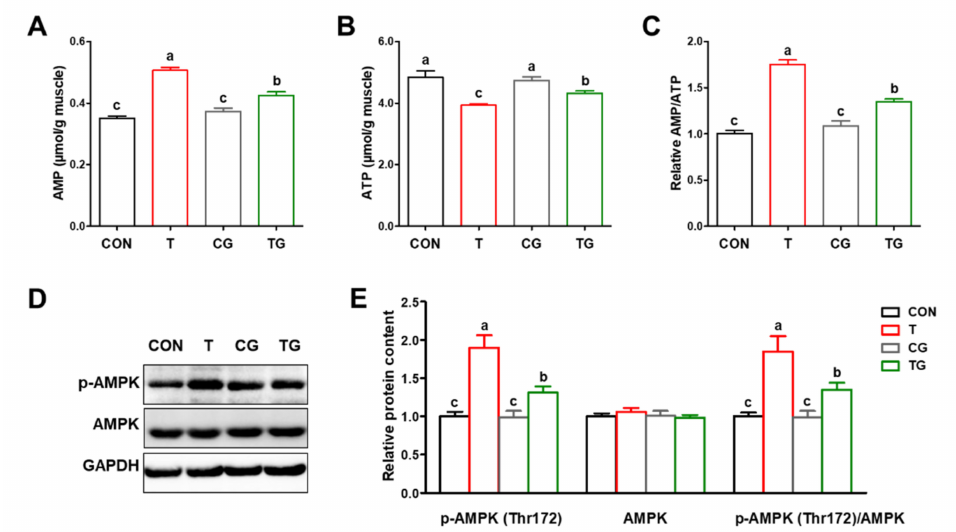
Figure 4. Effects of heat shock protein 70 expression on energy status and activation of AMPK in pectoralis major muscles of broiler chickens subjected to pre-slaughter transport. ( A ) AMP content. ( B ) ATP content. ( C ) AMP/ATP ratio. ( D , E ) Phosphorylated/total AMPK contents. CON,